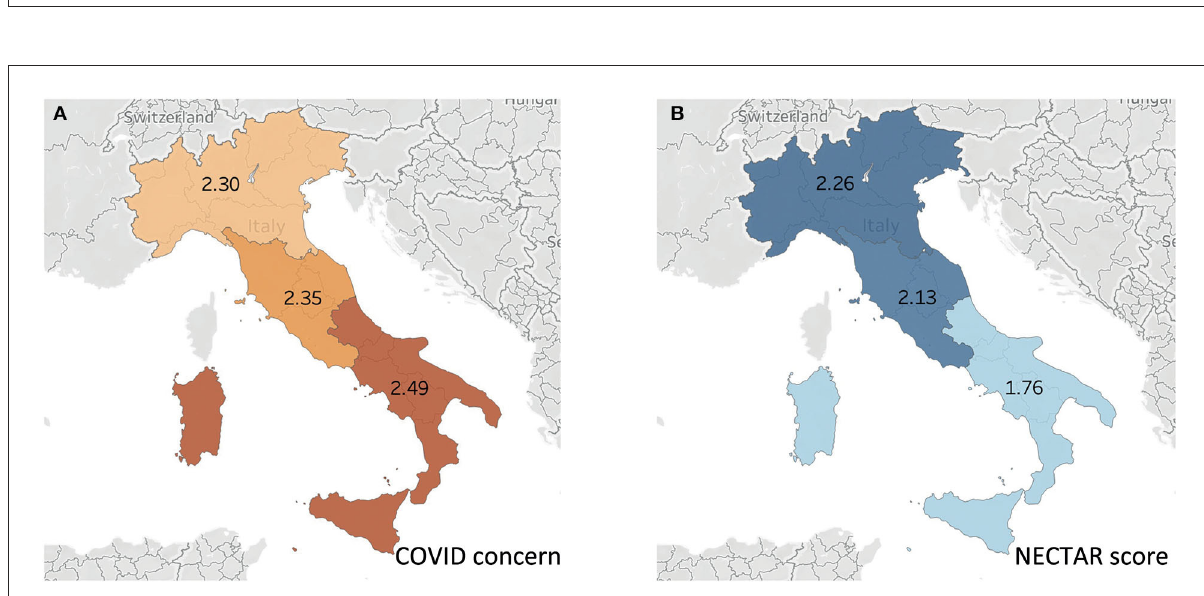
FIGURE7 Geographical distribution of COVID-19 concern (A) and NECTAR score (B) in different Italian zones.